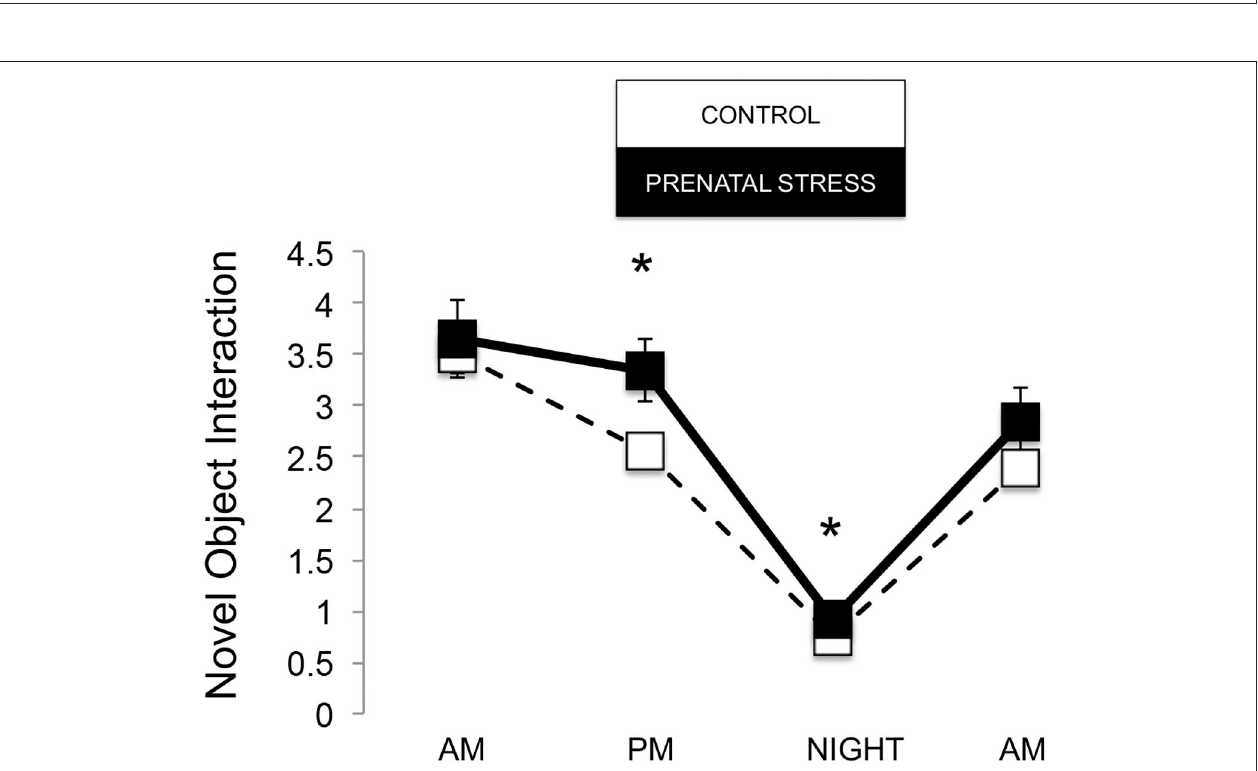
FIGURE 3 | Novel object interaction during biobehavioral assessment between offspring of prenatally stressed mothers ( n = 39) and control mothers ( n = 149). Means are presented ± standard error of the mean. * p < 0.05.